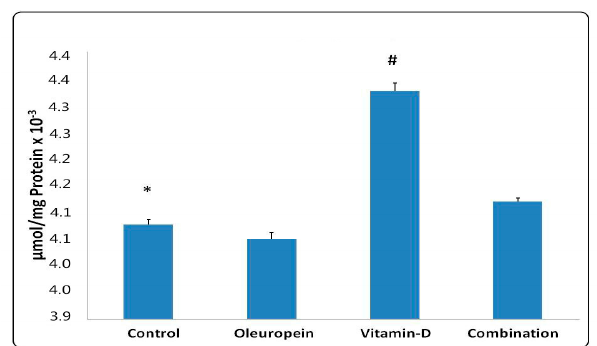
Figure 6. Nitric oxide analysis results. # Vitamin D treatment has significantly increased NO as compared to other groups ( p <